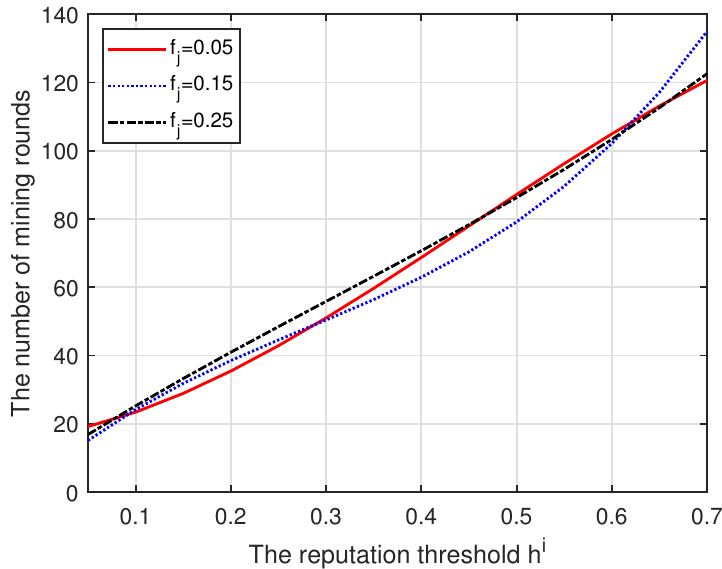
Figure 6. Reputation vs. Mining rounds.